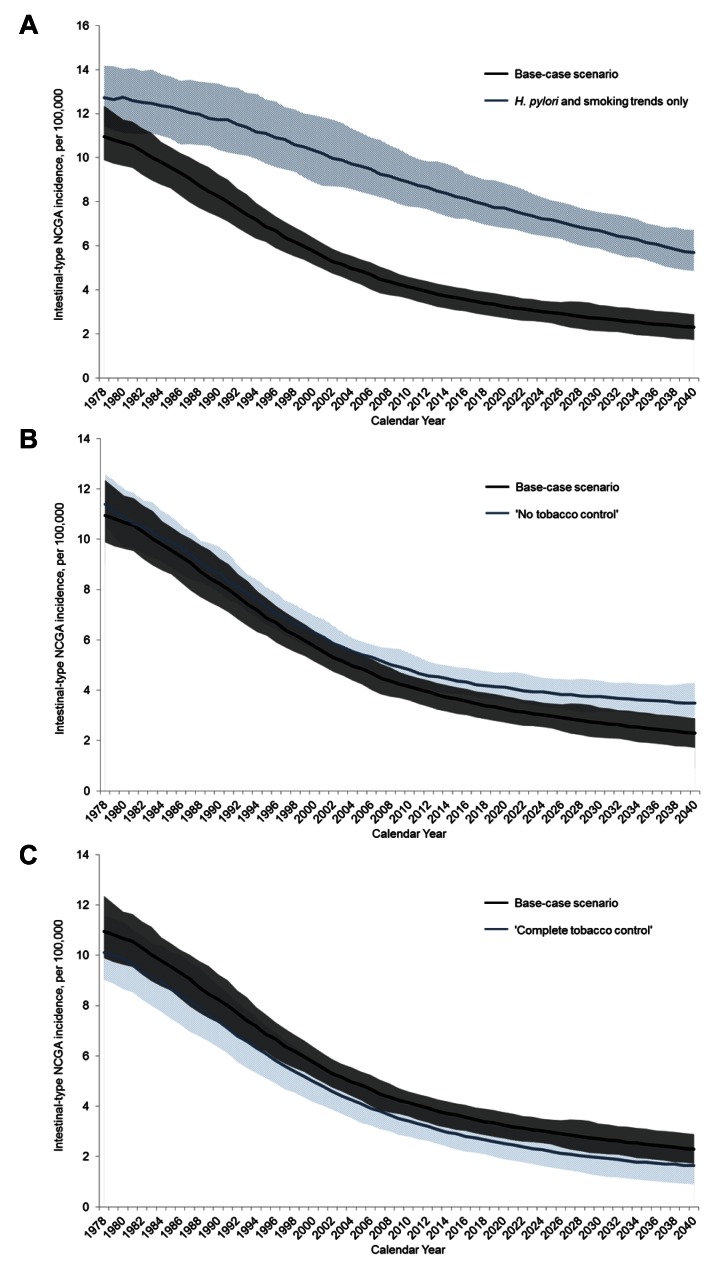
Modeled age-standardized intestinal-type NCGA incidence between 1978 and 2040 for select scenarios.(A–C) Age-standardized intestinal-type NCGA incidence for select scenarios. Mean (solid line) and range (shaded area) among the 50 randomly selected good-fitting parameter sets are shown. (A) Cancer incidence for the base-case scenario (all risk factor trends) (black) and H. pylori and smoking only scenario (light blue). (B) Cancer incidence for the base-case scenario (black) and “no tobacco control” scenario (light blue). (C) Cancer incidence for the base-case scenario (black) and “complete tobacco control” scenario (light blue). Ranges were calculated across all 50 parameter sets and smoothed with a 3-y moving average.